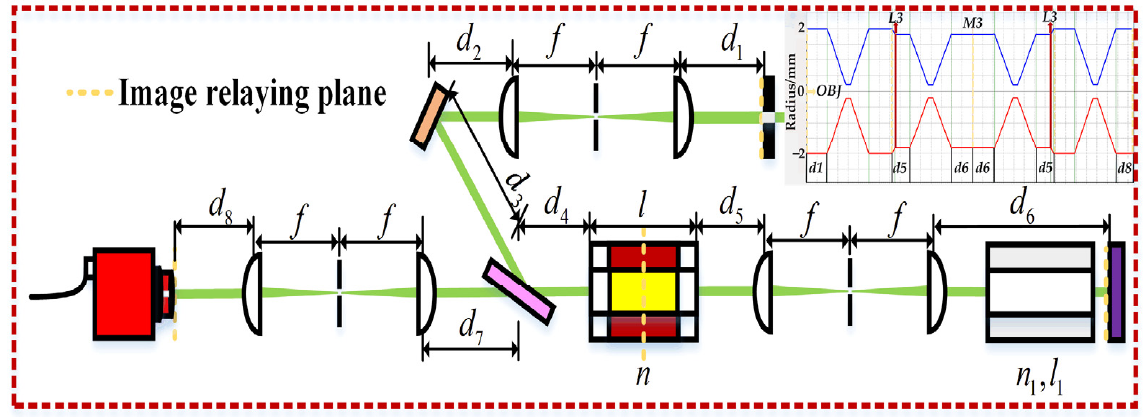
Figure 6. Schematic diagram of image relaying optical path of double ‐ pass amplifier.